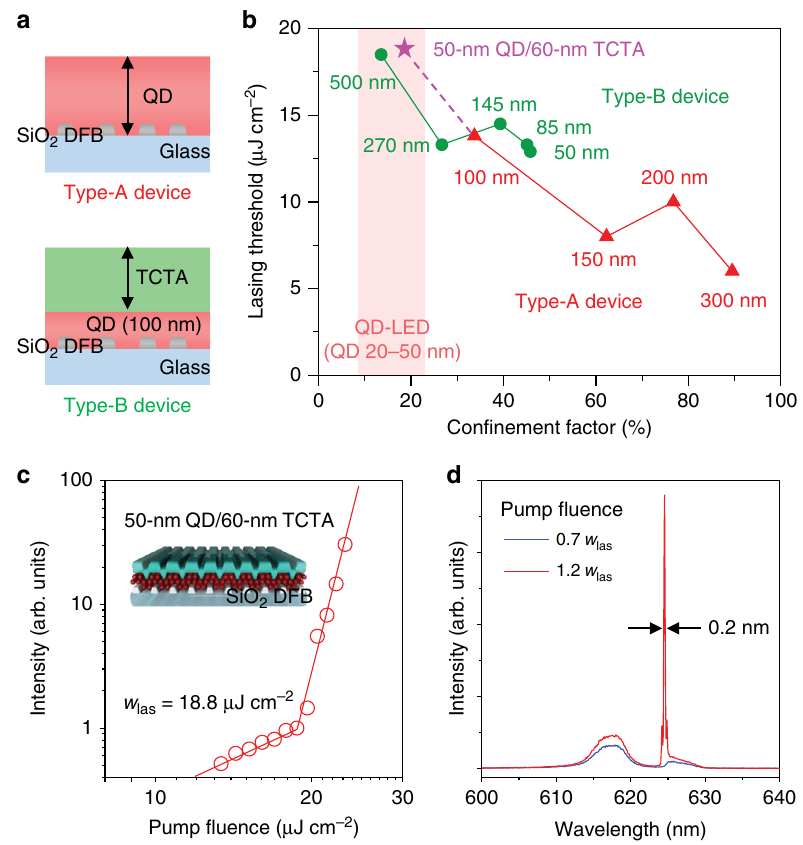
Fig. 3 Effect of mode con fi nement factor on lasing. a In type-A (top) and type-B (bottom) devices, the mode con fi nement factor is tuned by varying, respectively, the thickness of the QD active region ( H QD = 50 – 300 nm) or the top TCTA layer ( H TCTA = 50 – 500 nm; H QD is fi xed at 100 nm). b Lasing threshold versus Γ QD for type-A (red) and type-B (green) devices. A type-A device with H QD = 50 nm does not lase due to the lack of a supported waveguided mode. However, lasing restores (magenta data point) upon addition of a 60-nm TCTA layer, which helps recover the device